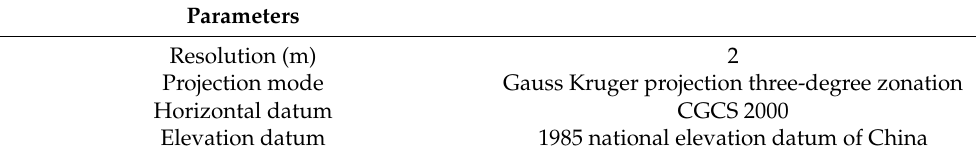
Table 3. Basic parameters of the used DSM